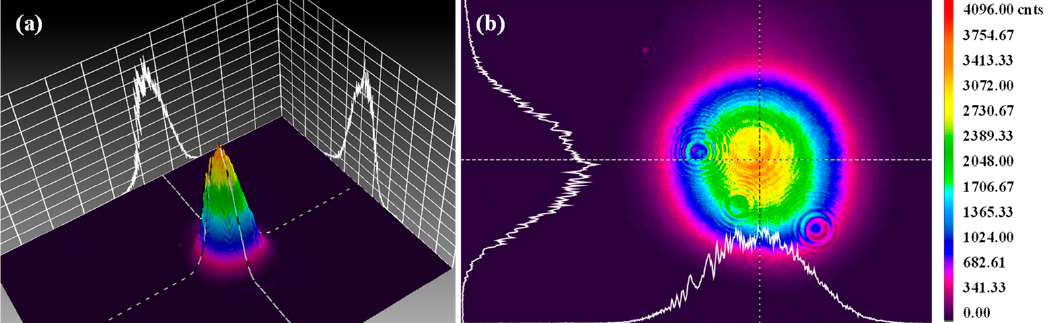
Figure 3. Energy density distribution in the spot of the experimental laser source. ( a ) Three-dimensional energy density distribution; ( b ) two-dimensional energy density distribution.